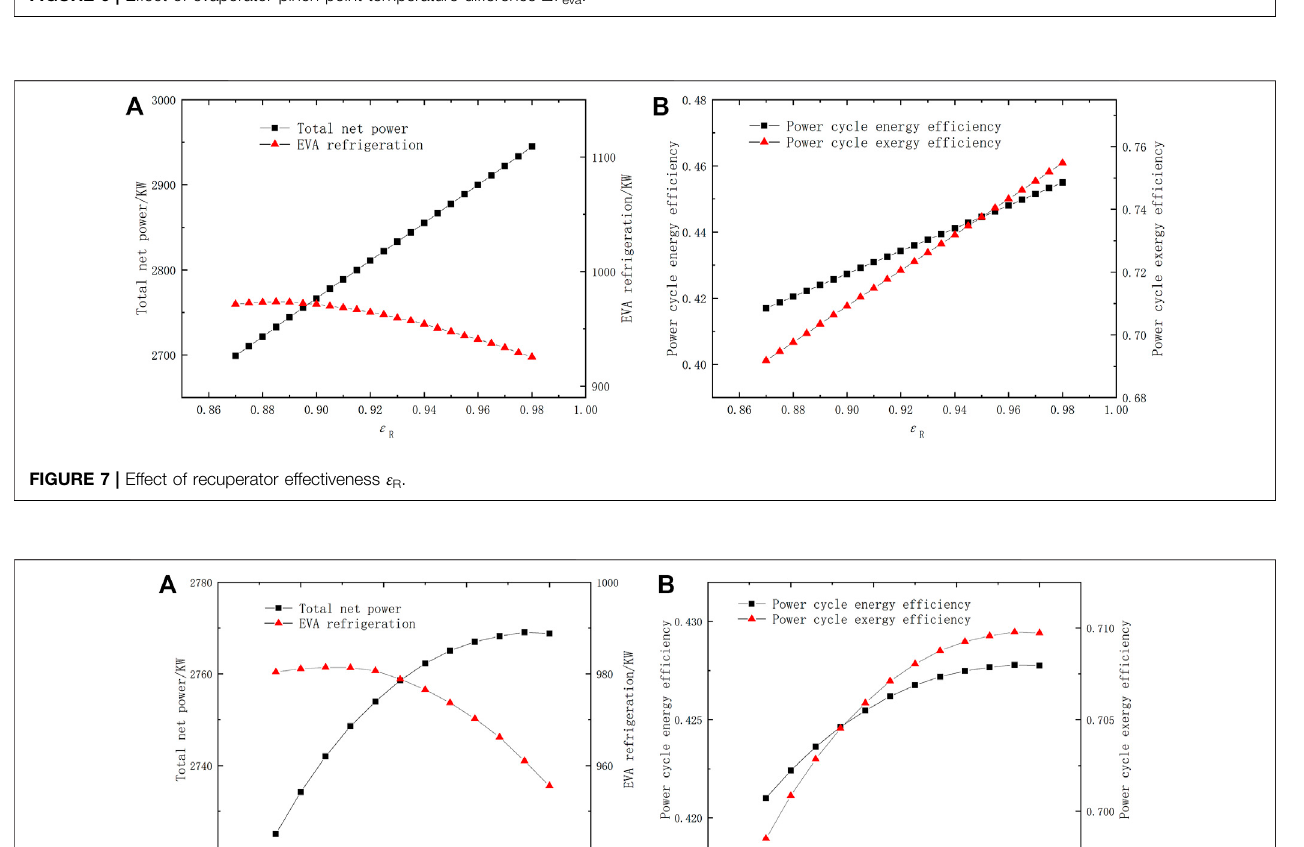
FIGURE 6 | Effect of evaporator pinch point temperature difference Δ T eva .